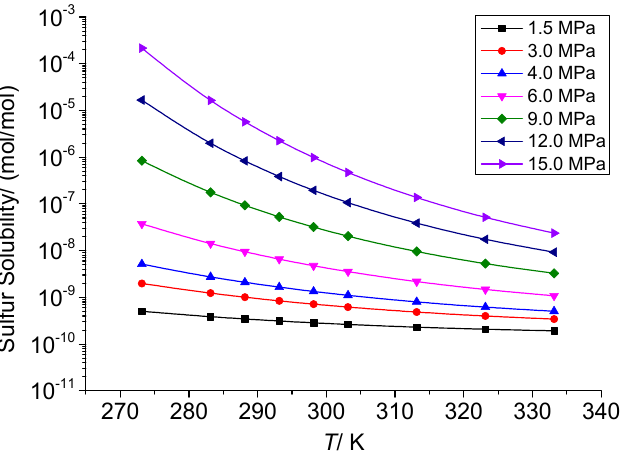
Figure 5. Chemical solubility curve of elemental sulfur in acid gas 3.